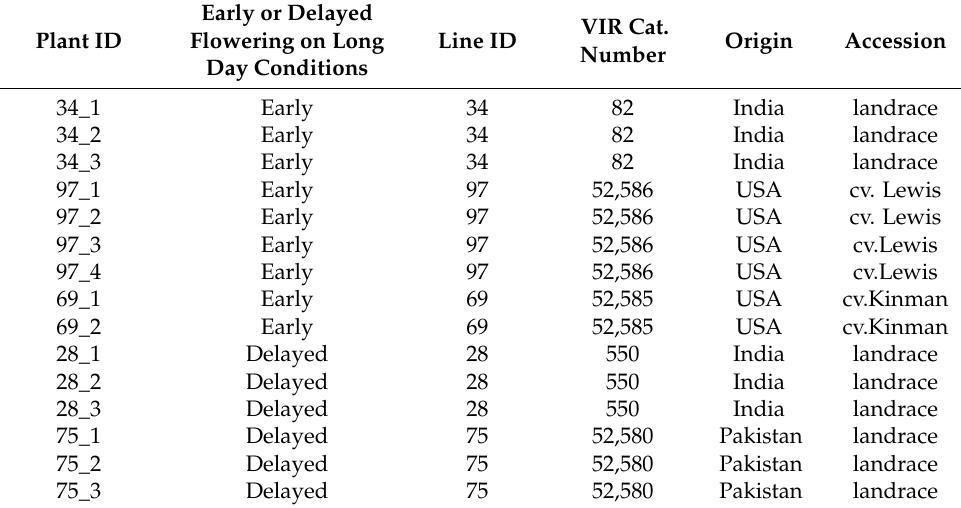
Table 1. Guar lines with different photoperiod sensitivity that showed consistent early or late flowering time in experiments of 2018 and 2019 under the long day conditions. Early or Delayed VIR Plant ID Flowering on Long Line ID Day Conditions